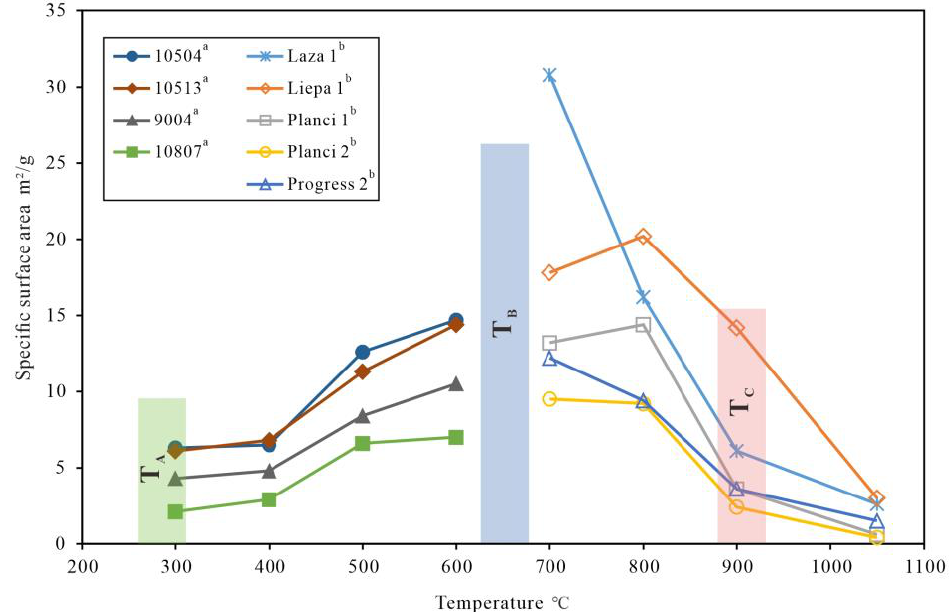
Figure 8. Effect of temperature on the specific surface area of shale samples and clay minerals. Left: Four groups of data on shale samples, referenced and adapted with permission from Ref. [42], marked with “ a ” . These shale samples were not treated with hydrochloric acid, and the carbonate minerals were largely decomposed when the temperature was higher than 600 °C, which increased the SSA of the shale samples. Therefore, only data for temperatures lower than 600 °C can represent the pyrolysis characteristics of T A and T B in this experiment. Right: Five groups of data on clay minerals, referenced from Dabare and Svinka [80], marked with “ b ” . The changes in SSA in several clay minerals (calcination at 700−1050 °C) were not affected by the thermal decomposition of carbonate. Moreover, the composition of the main inorganic minerals was basically consistent with that of T HCl , so this study can approximately reflect the changes in the SSA of T C in this